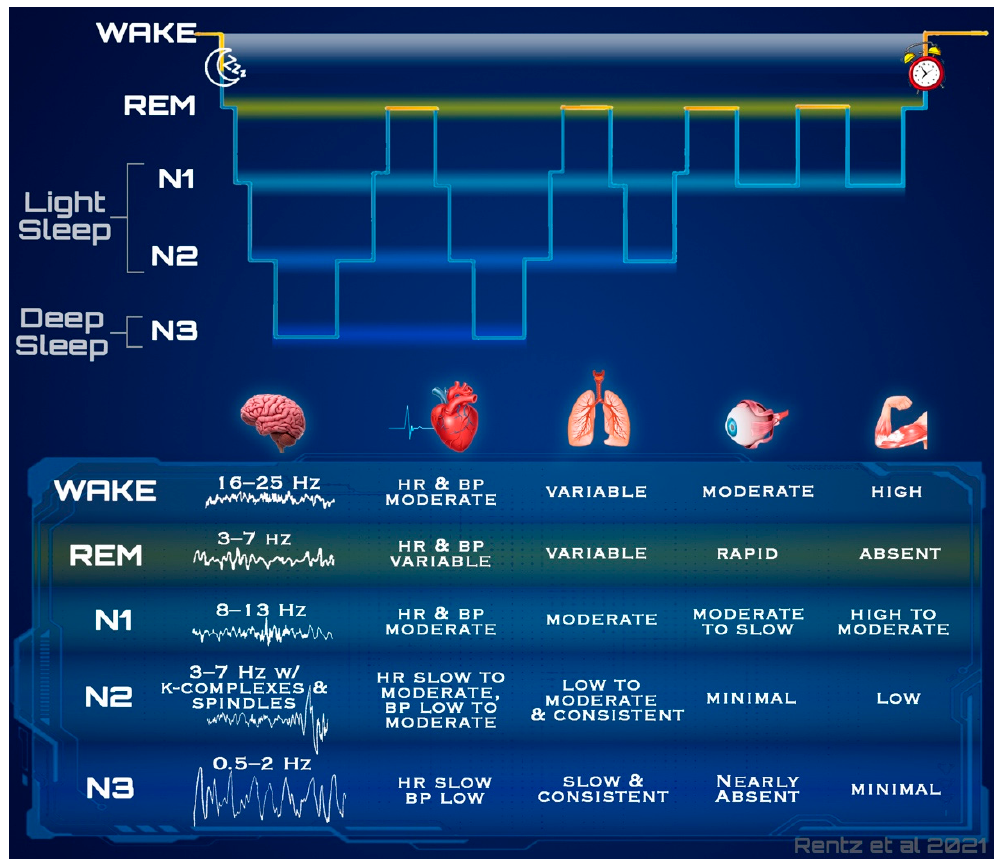
Figure 1. Systematic occurrences during wake and sleep. The figure demonstrates the minor physiological differences between wake and each of the sleep stages. Normal structural progression, displayed in the hypnogram at the top of the figure provides context surrounding the frequent shifts between states, and the subsequent reliance for accurately capturing physiological trends. Prominent physiological trends often characteristic of these individual states, which are each traditionally measured via separate methods, are comparable including brain activity, cardiac patterns (heart rate and blood pressure), respirations, eye movement, and muscle tone. REM physiology depicted is most representative of phasic REM. (BP, blood pressure; HR, heart rate; Hz, hertz; N1, non-rapid eye movement stage 1; N2, non-rapid eye movement stage 2; N3, non-rapid eye movement stage 3; REM, rapid eye movement).